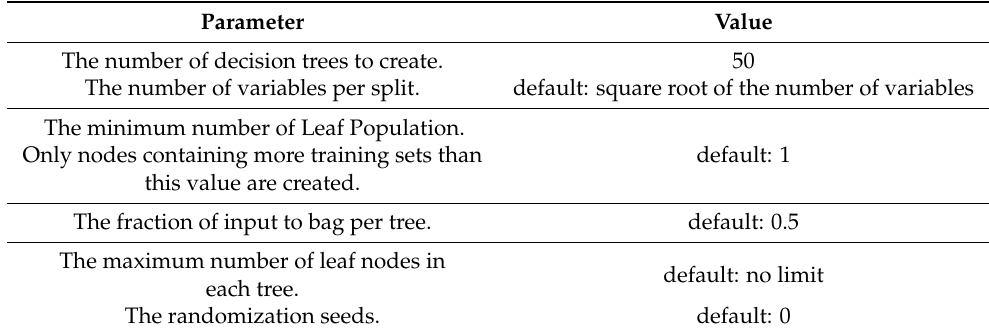
Table 5. Parameters used for training in